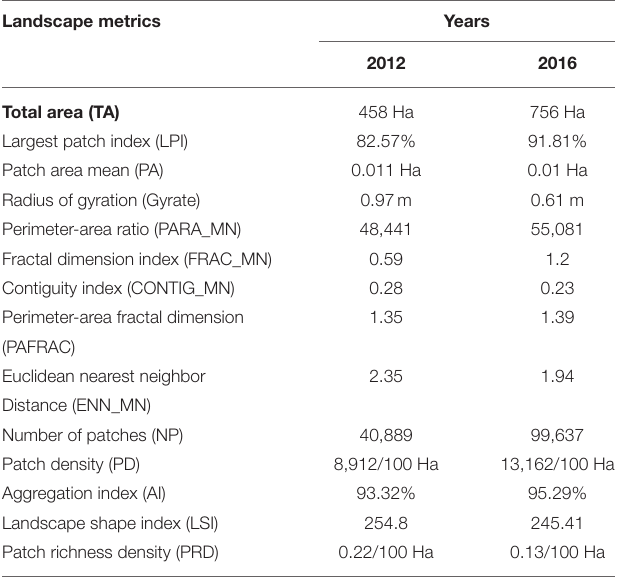
TABLE 7 | Landscape metrics of urban areas in 2012 and